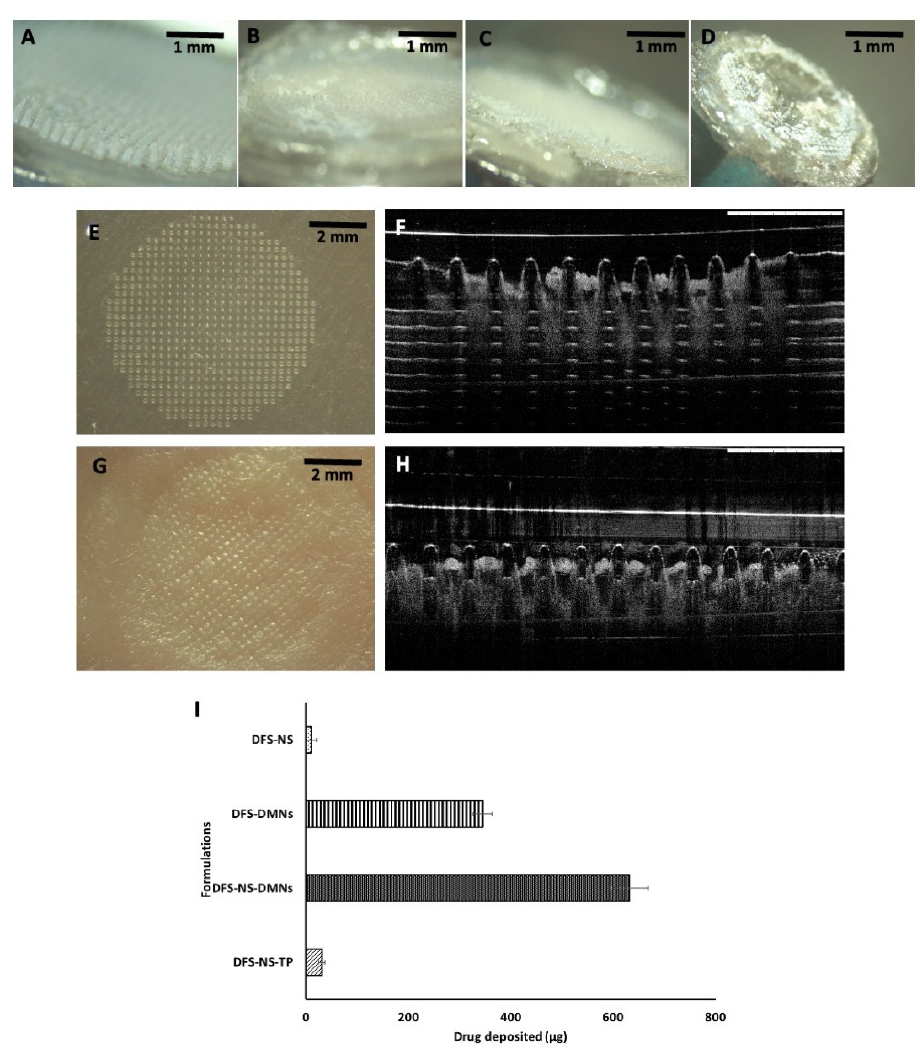
Figure 7. Dissolution study of DFS ‐ NS ‐ DMNs after insertion into excised porcine skin. Images taken after ( A ) 10 min of insertion, ( B ) 15 min of insertion, ( C ) 30 min of insertion, and ( D ) 60 min of insertion. Digital and OCT images of DFS ‐ NS ‐ DMNs; ( E , F ) DFS ‐ NS ‐ DMNS inserted in parafilm layers, ( G , H ) DFS ‐ NS ‐ DMNs inserted into excised porcine skin. ( I ) DFS deposited in excised porcine skin following the insertion of DFS ‐ NS, DFS ‐ DMNs, DFS ‐ NS ‐ DMNs, and DFS ‐ NS ‐ TP (without needles). Data are expressed as the mean ± SD, n = 3.